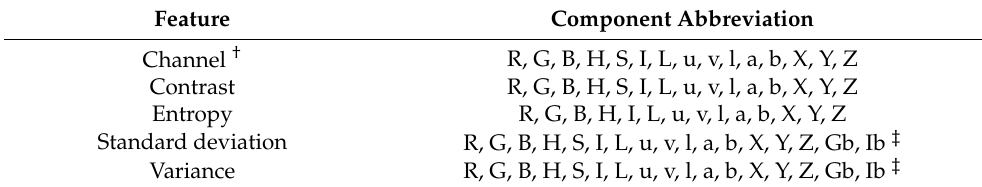
Table 1. Suggested set of features for the FCM classifier.